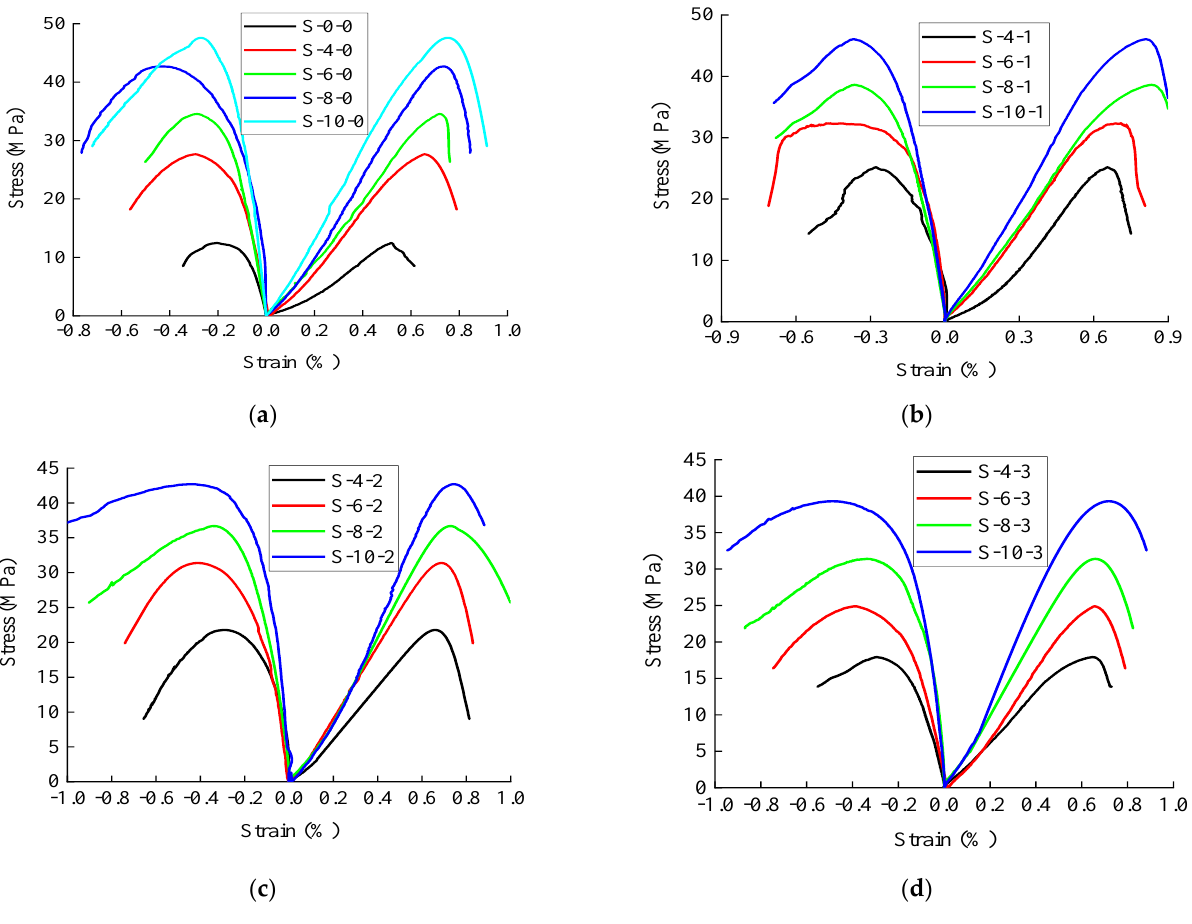
Figure 7. Stress – strain curves: ( a ) seepage pressure is 0 MPa, ( b ) seepage pressure is 1 MPa, ( c ) seepage pressure is 2 MPa, and ( d ) seepage pressure is 3 MPa.